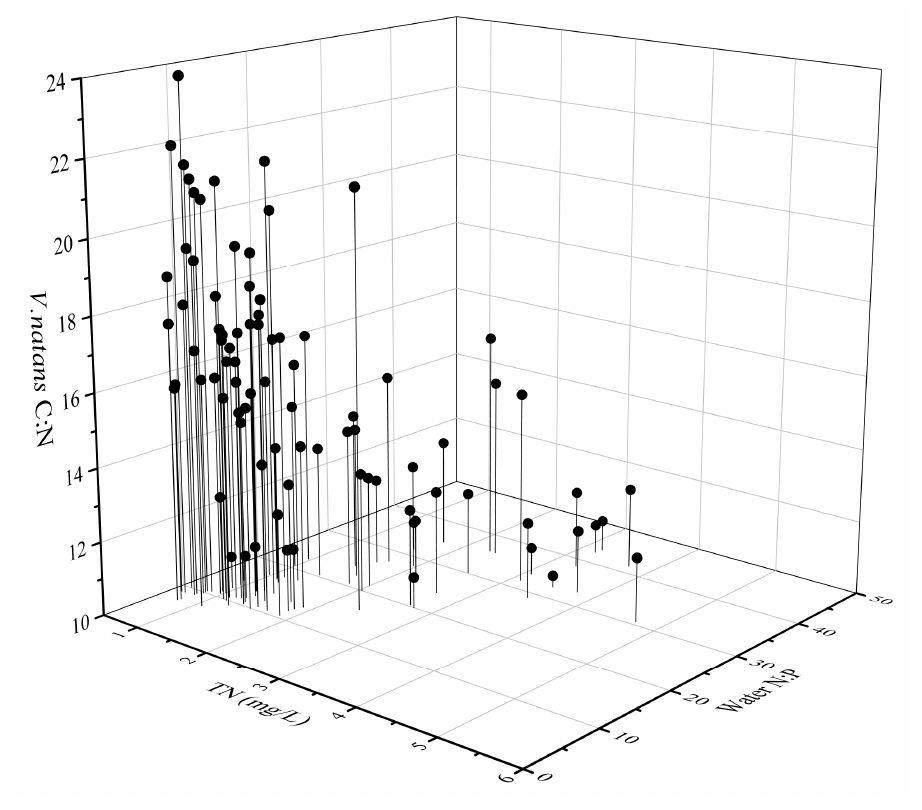
Figure 5. The relationship between V. natans C:N, water TN, and water N:P. Table 6. Summary of the best model of the relationship between V. natans N and water N:P.